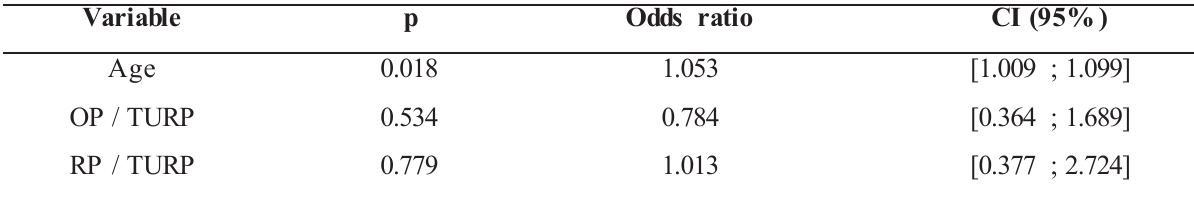
Table 4 - Logistic regression model for the presence of UI.